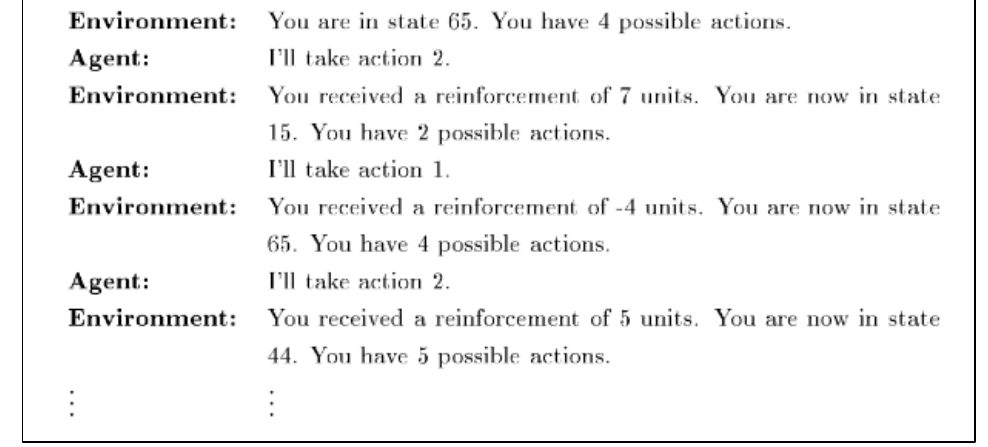
Figure 4: Reinforcement Learning Cycle. Source: [20]. (North, East, South and West, respectively, meaning North, East, South and West).